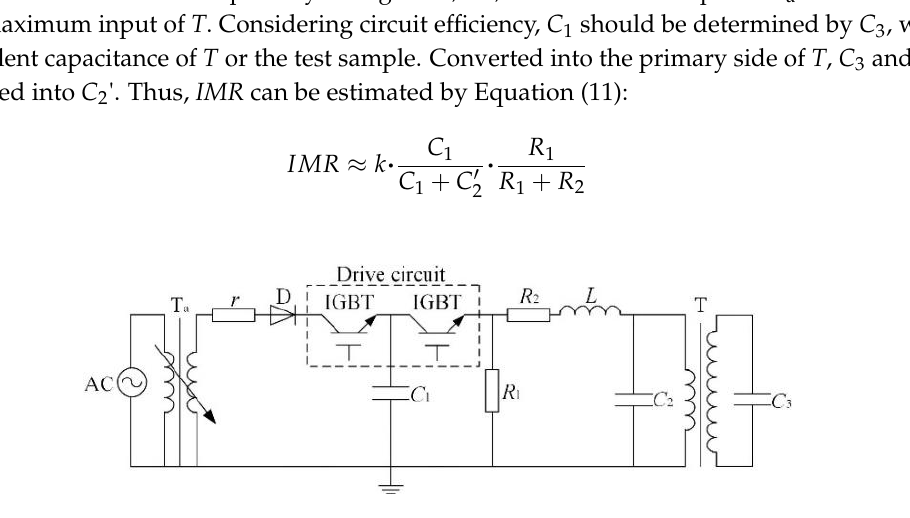
10 of 15 Figure 13. Diagram of the charging circuit. AC: alternating current. Changing the polarity of the output can be achieved by reversing the connections of diode D and the IGBT. After the IGBT is turned on, main capacitor C 1 can be fully charged within 3–5 time